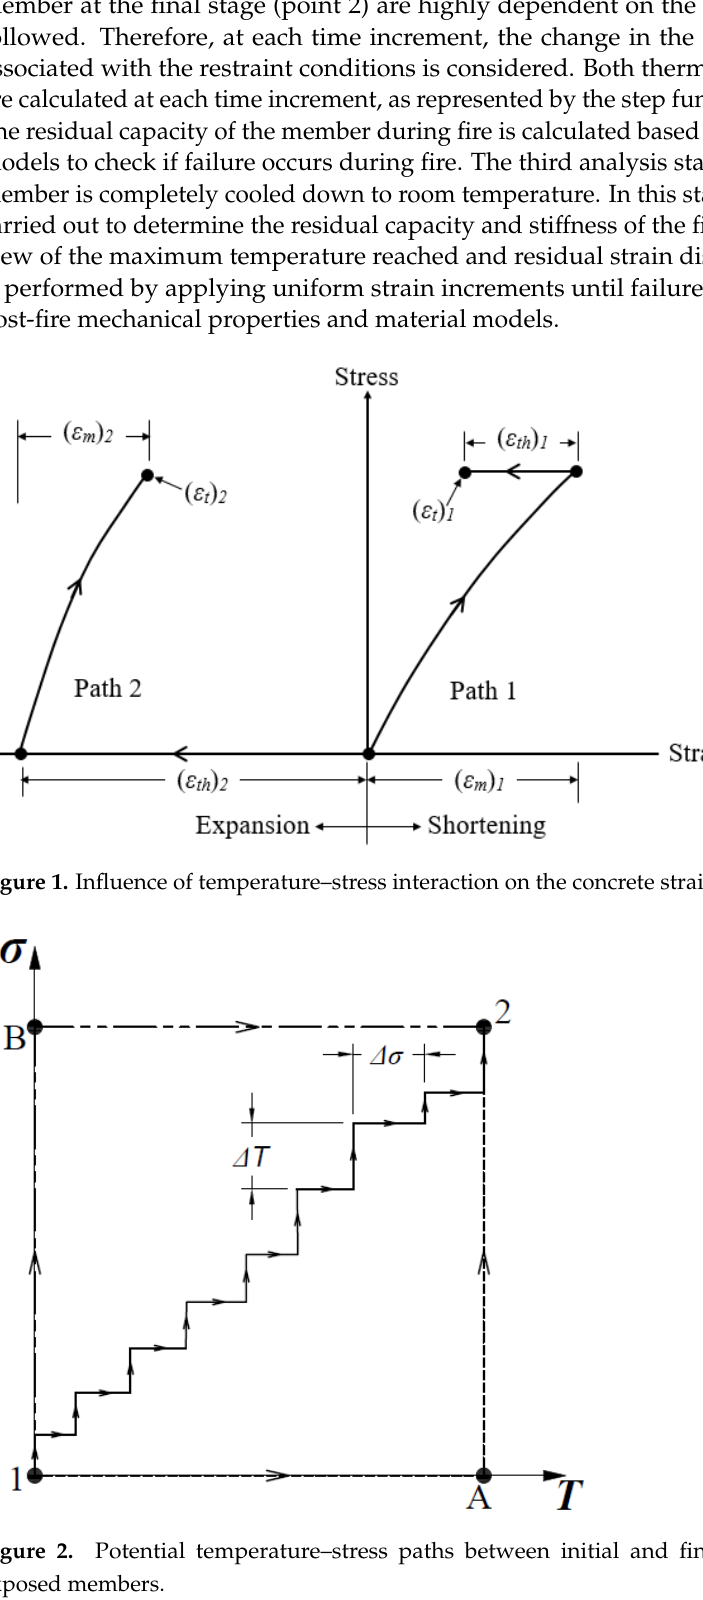
Figure 1. Influence of temperature–stress interaction on the concrete strains.